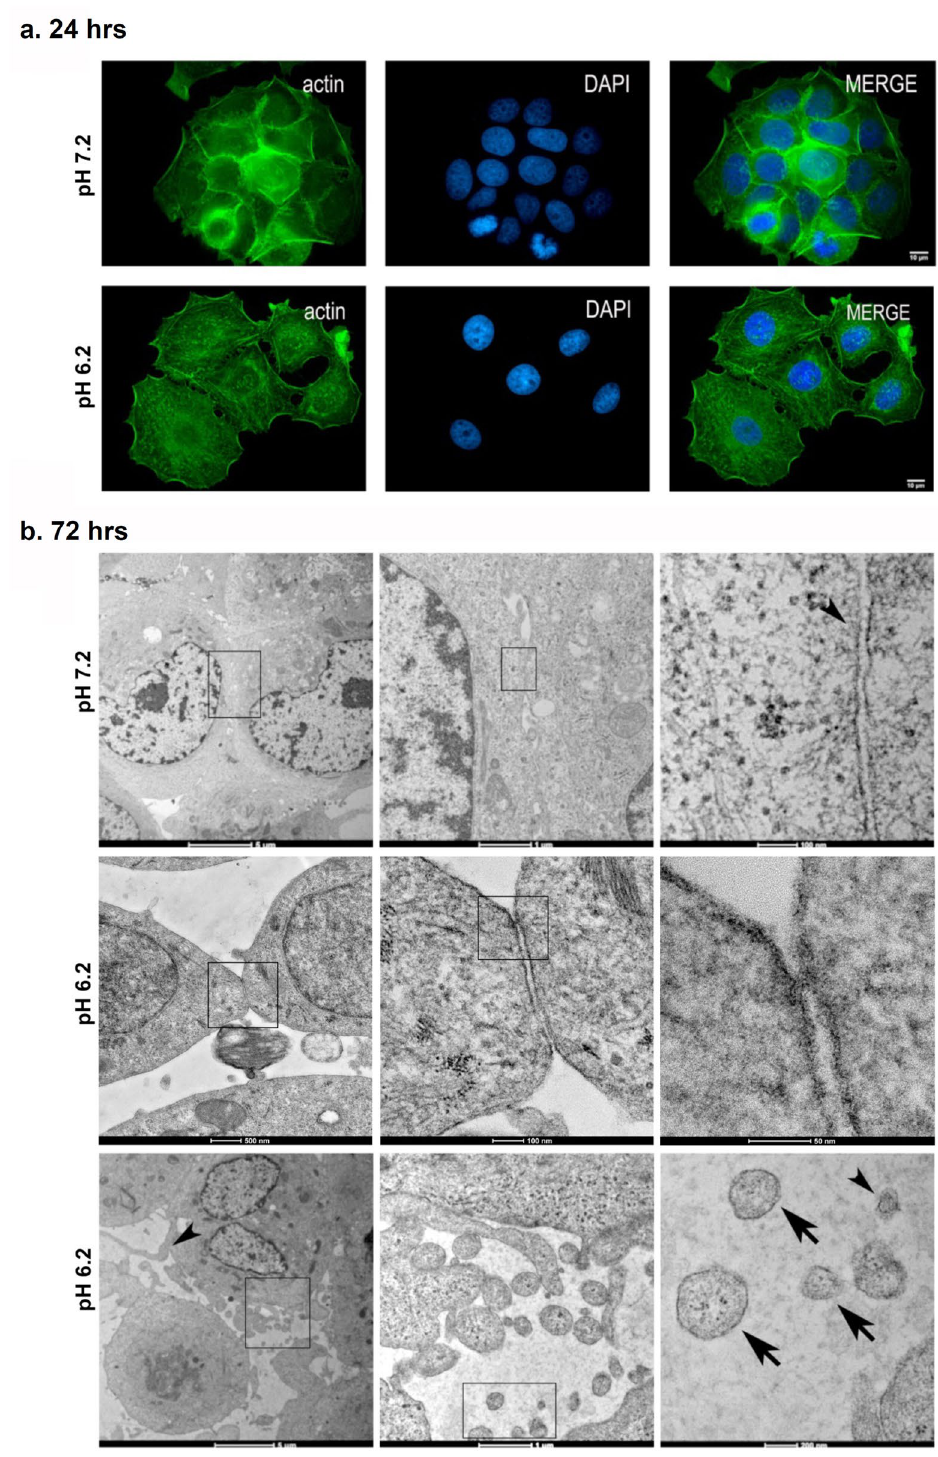
Figure 2. Acidic pH disrupts MCF 7 mammary carcinoma intercellular junctions and induces extracellular vesicle formation. ( a ) Cytoplasmic actin and nuclei were visualized by fluorescence staining with Phalloidin- Alexa 488 (green) and DAPI (blue) after 24 h growth at pH 7.2 or 6.2 and visualized by confocal microscopy as indicated. ( b ) Cell morphology was examined by transmission electron microscopy after 72 h growth at pH 7.2 or 6.2 as indicated. Cells grown at pH 7.2 display normal intercellular junctions (arrowheads). In contrast, cells grown at pH 6.2 display distinct heterochromatin disposition and wider spaces between cells (arrowheads), as well as structures suggestive of microvesicles (arrows) and exosomes (arrowhead). Boxes in each image indicate progression magnifications moving from left to right hand